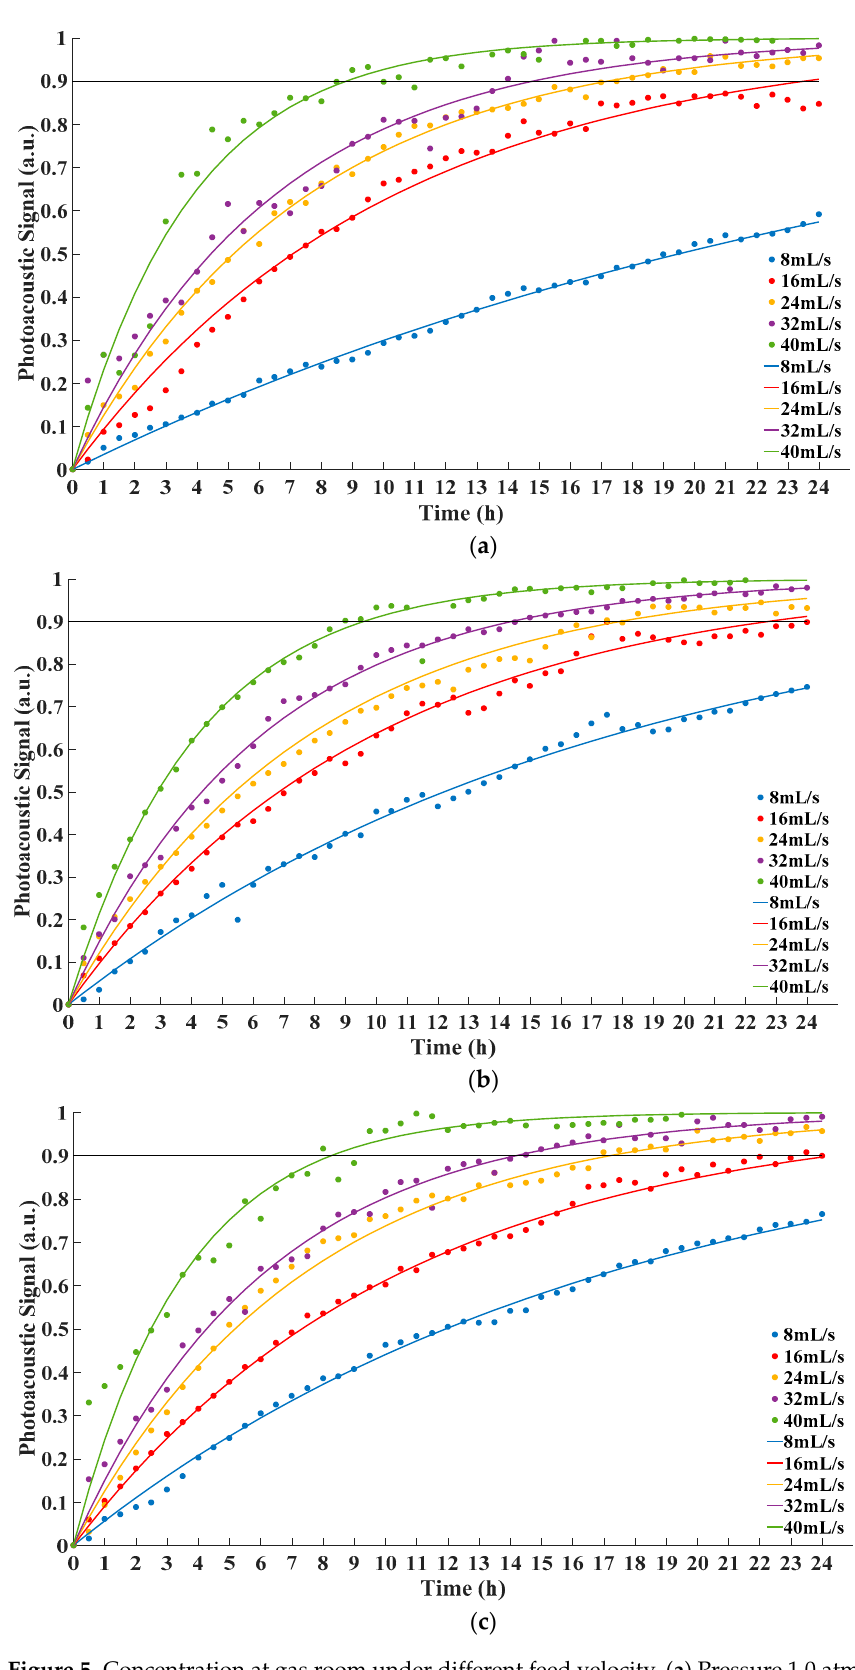
Figure 5. Concentration at gas room under different feed velocity. ( a ) Pressure 1.0 atm; ( b ) Pressure 1.5 atm; ( c ) Pressure 2.0 atm.